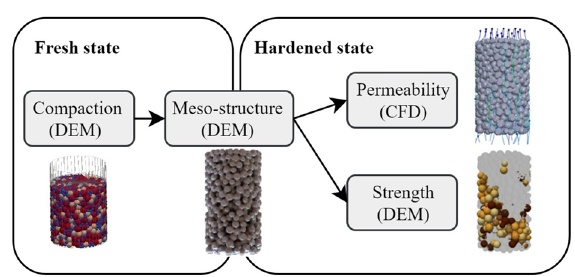
Figure 5 . Modelling strategy to assess the permeability and strength of PC